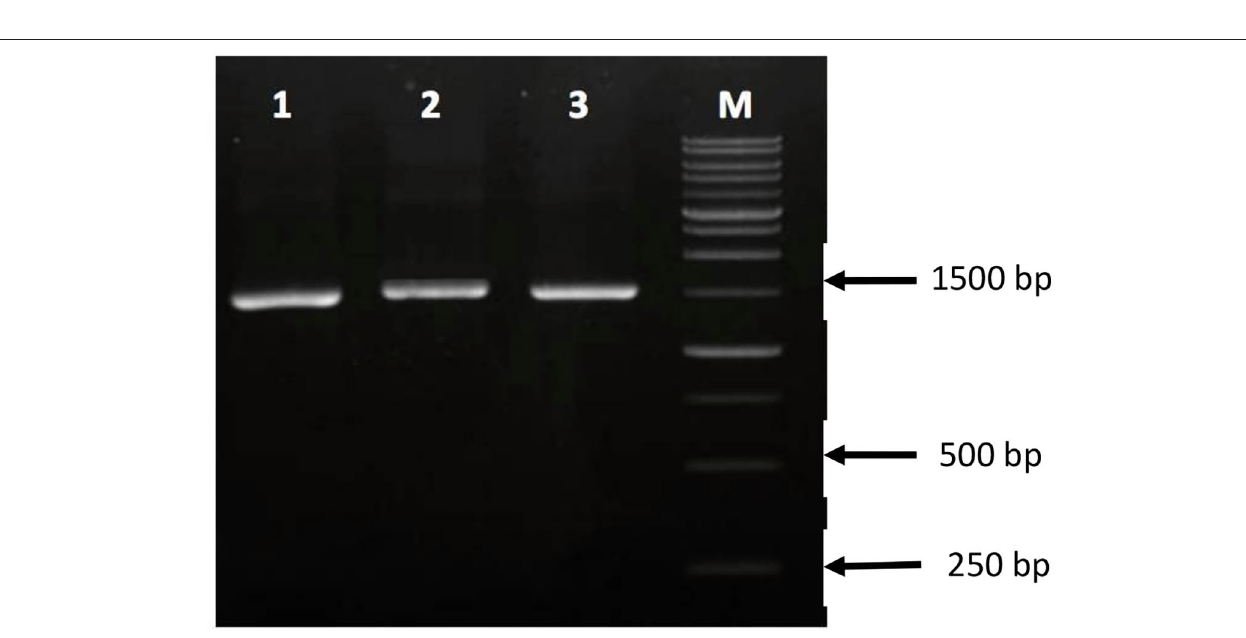
FIGURE 2 | PCR amplification of 16S rRNA genes on agarose gel. 1. Isolate Sr3; 2. Isolate Jg8; 3. Isolate Rg1; and M. 1kb DNA